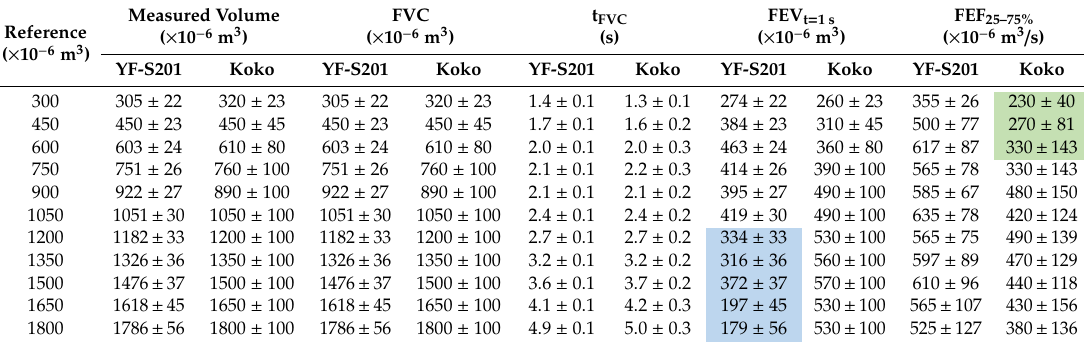
Table 5. Comparison between spirometric results of Koko and the sensor developed in this